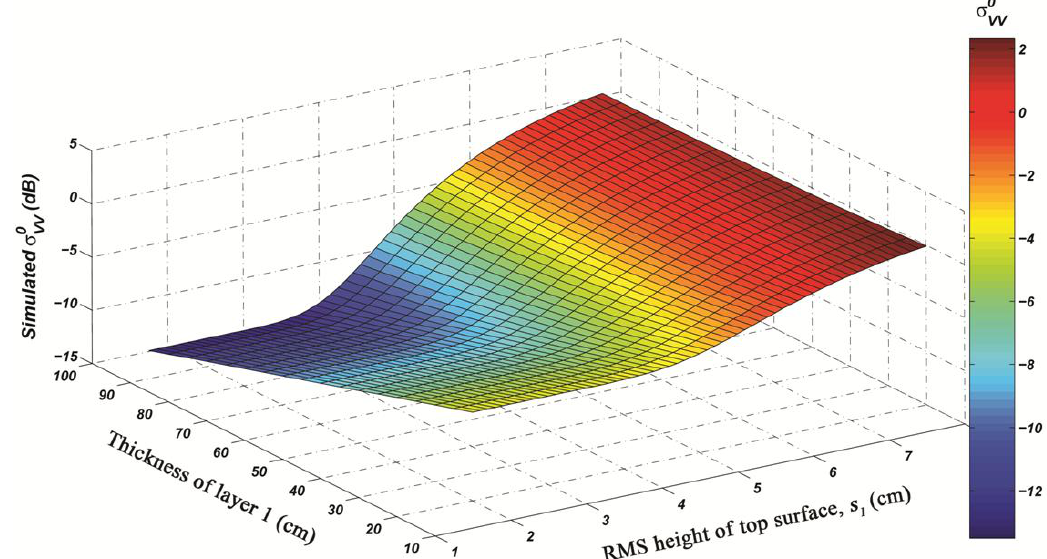
Figure 8. The variation patterns of simulated σ° VV polarization, 25.6° incidence angle, ε s = 0.4 cm, l = 6.0 cm) with RMS height of surface and thickness of layer 1. Different 2 2 colors represent different levels, and corresponding color bar is